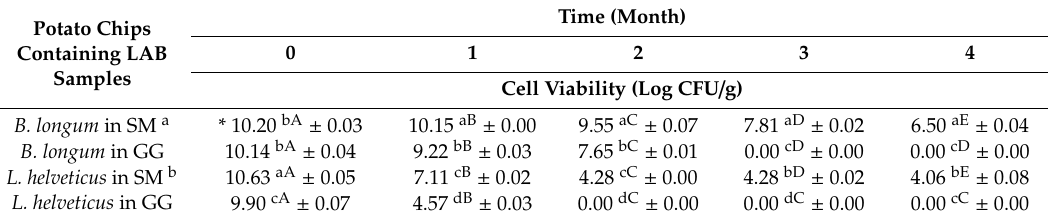
Table 3. Viability of lyophilized probiotic lactic acid bacteria (LAB) in the stored potato chips.